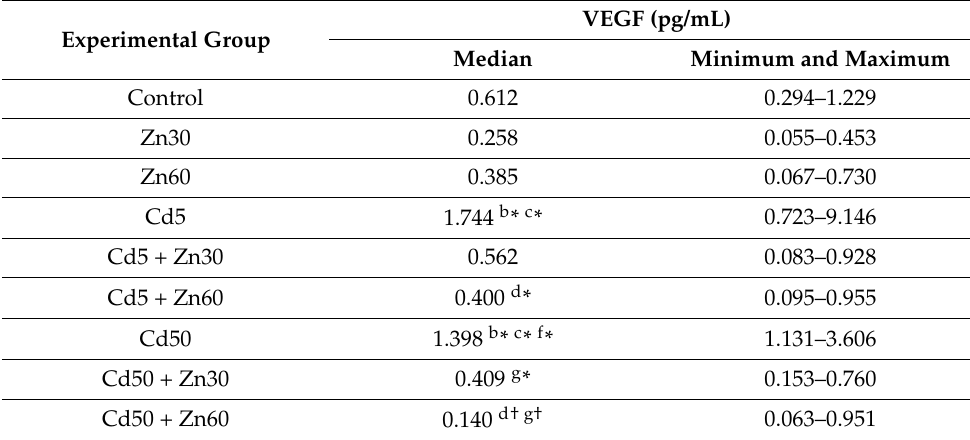
Table 5. The concentration of VEGF in the serum in particular experimental groups 2 . VEGF (pg/mL) Experimental Group Median Minimum and